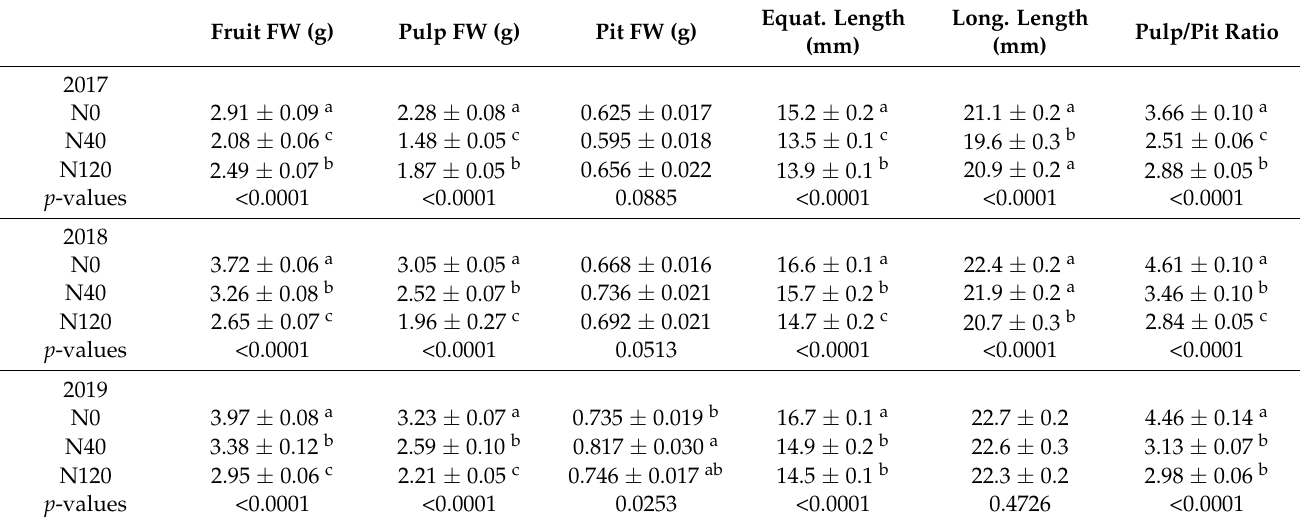
Table 1. Fruit, pulp and pit fresh weight (FW), longitudinal length, equatorial length and pulp/pit ratio (FW) of olives from olive trees supplied with 0 (N0), 40 (N40) and 120 (N120) kg ha − 1 of N in the harvests of 2017, 2018 and 2019. Equat. Length Long.